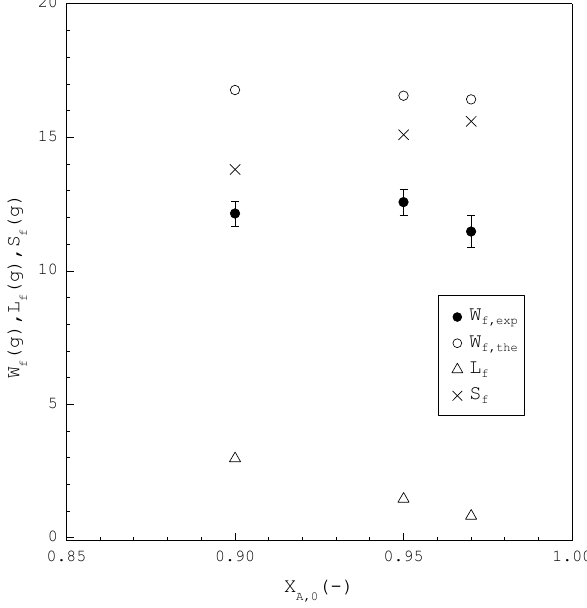
Figure 11. Comparison of 𝐿 𝑓 , 𝑆 𝑓 , 𝑊 𝑓,𝑡ℎ𝑒 and 𝑊 𝑓,𝑒𝑥𝑝 of the final product plotted against 𝑋 𝐴,0 for the purification of m -chlorophenol. Each solid circle data point represents the average 𝑊 𝑓,𝑒𝑥𝑝 for four repetitive experiments and error bar represents the 95% confidence interval for the experimental 𝑊 𝑓,𝑒𝑥𝑝 .